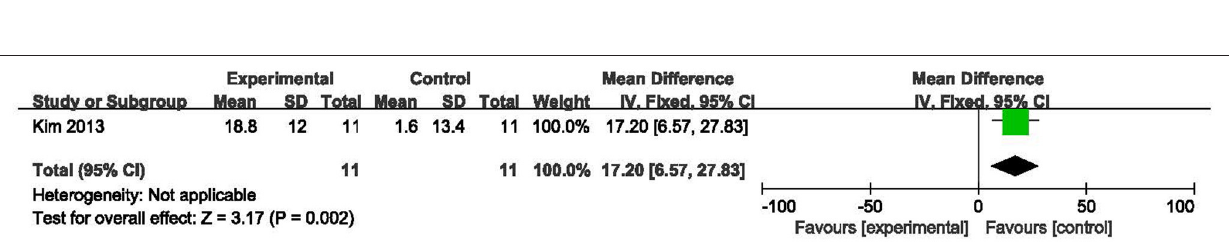
FIGURE 4 | Forest plot of network meta-analysis of the end-of-treatment effect on post-traumatic stress disorder symptom severity between cognitive behavioral therapy-long and cognitive behavioral therapy-brief.